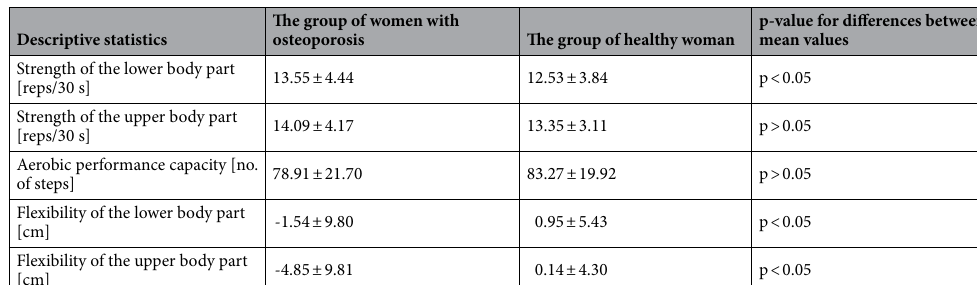
Within the Below the standard standard Above the